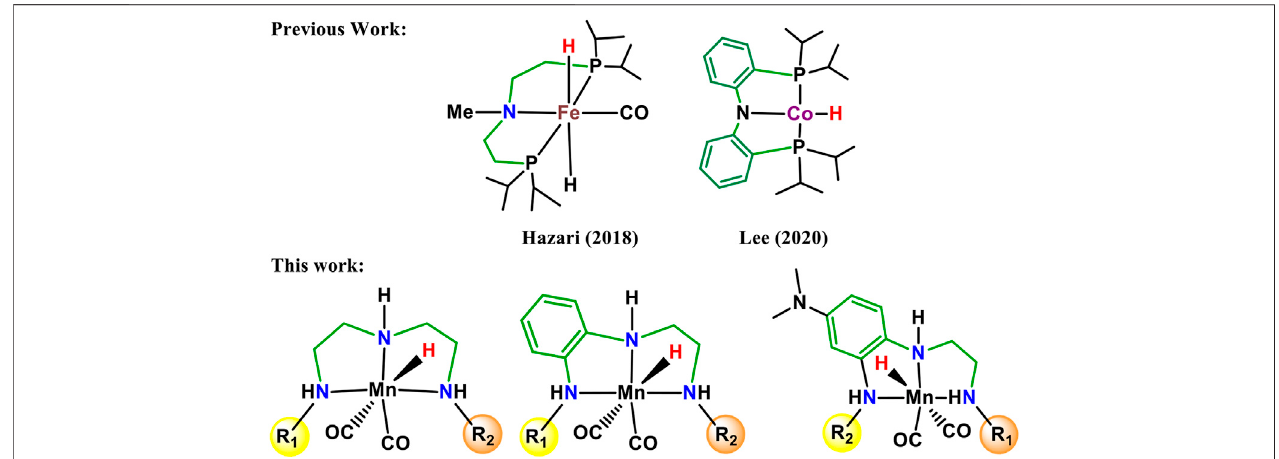
FIGURE 1 | Recently developed NNN pincer ligands with varying electron withdrawing and donating moieties.